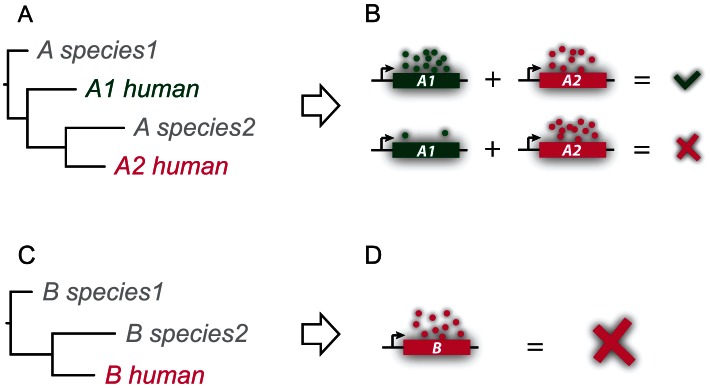
A model for the effect of functional compensation on the propagation of duplicated disease genes in the human population.This model is based on two previous experimental studies. The first showed that genes with identical promoters could have very different expression abundances in individual E. coli cells [33]. The second showed different C. elegans individuals carrying the defect gene could demonstrate varying phenotypes ranging from wild type to stalled development on embryogenesis, depending on the expression abundance of a duplicate gene [34]. We therefore propose that in cases where a duplicate (A1_human) exists (panel A), the functional impairment caused by mutations on a disease gene (A2_human) could be compensated; however due to intrinsic expression stochasticity of the duplicate copy, some individuals would appear to be normal while some others show reduced fitness (panel B). Consequently this gene A2 is linked to genetic disorders while the deleterious mutations it carries continue to spread instead of being removed in the human population. On the other hand, if a disease gene (B_human; panel C) is a singlet without any paralogs, its mutations then would be more likely to be purged from the population (panel D) since compensation by non-duplicates via genetic interactions is relatively rare [16], [17].